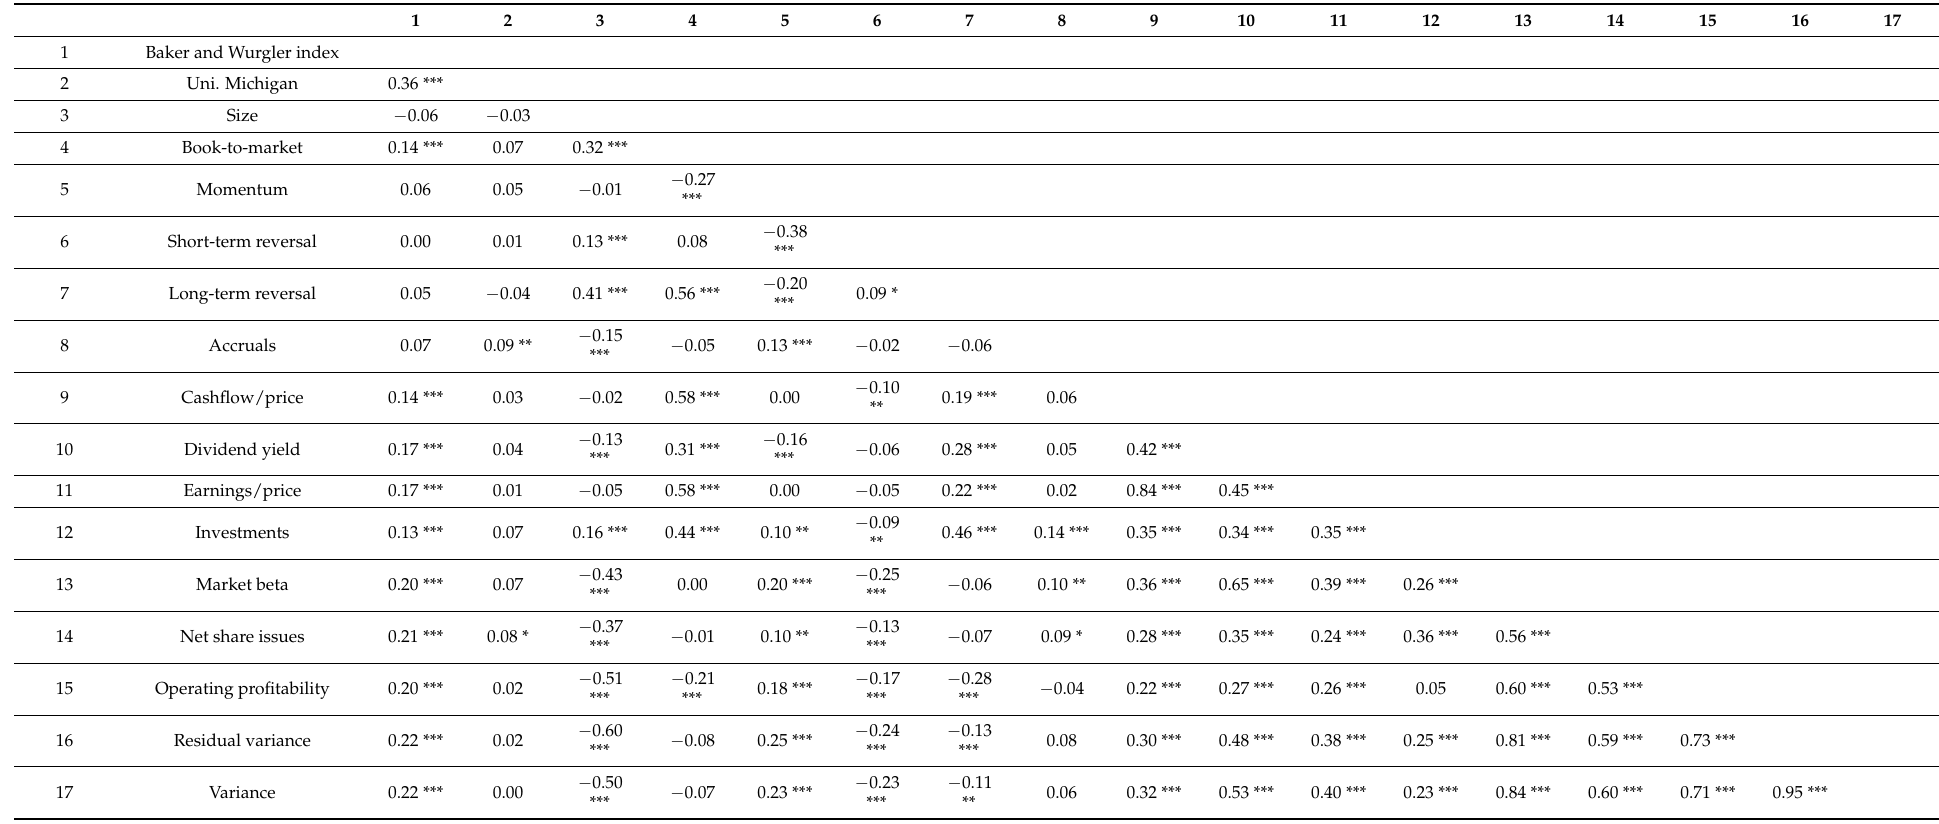
Table 5. Correlation